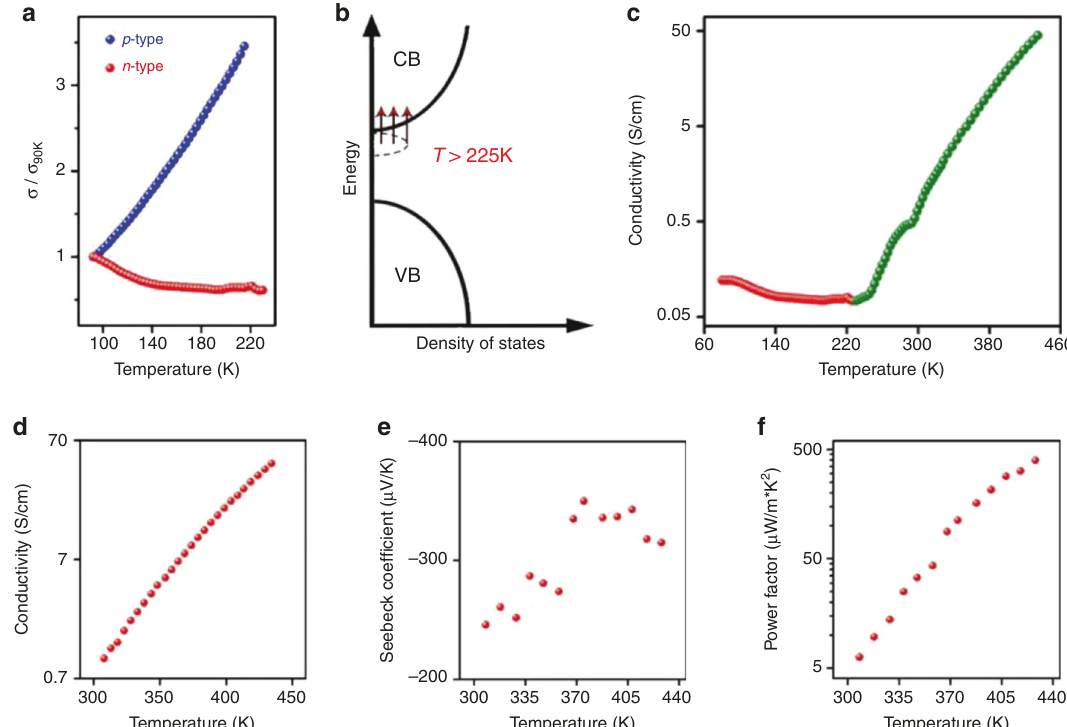
Fig. 6 Thermoelectric transport properties in surface re-engineered tellurium nanowires. a Temperature-dependent conductivity ( σ ) measurements (from 90 to 225 K) on thin fi lms of undoped p -type (Te-PVP, blue spheres) and sulfur-doped n -type (Te – S 2 − , red spheres) tellurium nanowires normalized to the respective conductivity values at 90 K ( σ 90K ). While the undoped nanowire fi lms show activated (semiconductor-like) transport with conductivities increasing with increasing temperature, the doped nanowire fi lms demonstrate band-like transport with decreasing values of conductivities with increasing temperature. b Proposed doping scheme wherein sulfur dopes tellurium n -type and most of the electrons are located in the dopant band with the Fermi level inside the band (similar to a metal) at low temperatures (below 225 K), and hence the band-like transport behavior. Above 225 K, the electrons gain suf fi cient thermal energy to get promoted to the conduction band. c Temperature-dependent conductivity measurements for the n -type (Te – S 2 − ) samples